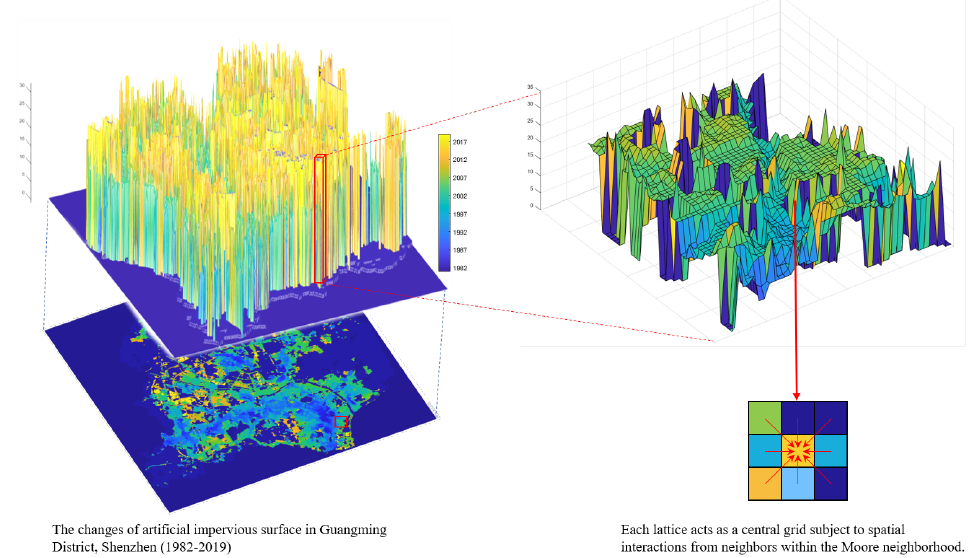
Figure 1. The changes in the impervious surface area in Guangming District, Shenzhen from the macro to the micro (1972–2019).